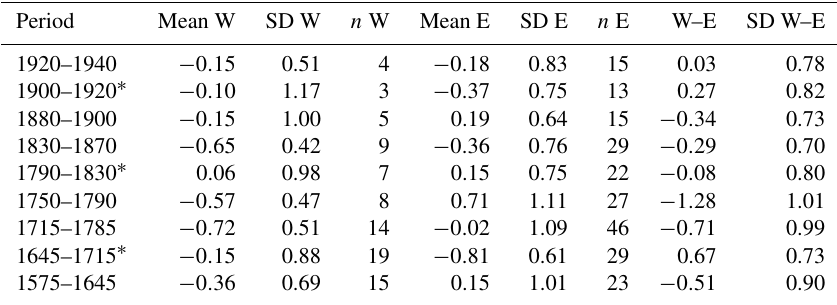
Figure 2. Correlation map between winter upward heat flux gradient (Aegean Basin versus Gulf of Lion difference) and winter mean geopotential height at 500mbar ( Z 500 (cid:48) ). The map reveals the Northern Hemisphere atmospheric pattern most closely related to EMT-type events. Table 1. Periods used to calculate western/eastern alkenone-based sea surface temperature (SST) gradient (W–E). Mean, standard deviation (SD) and number of cases ( n ) are